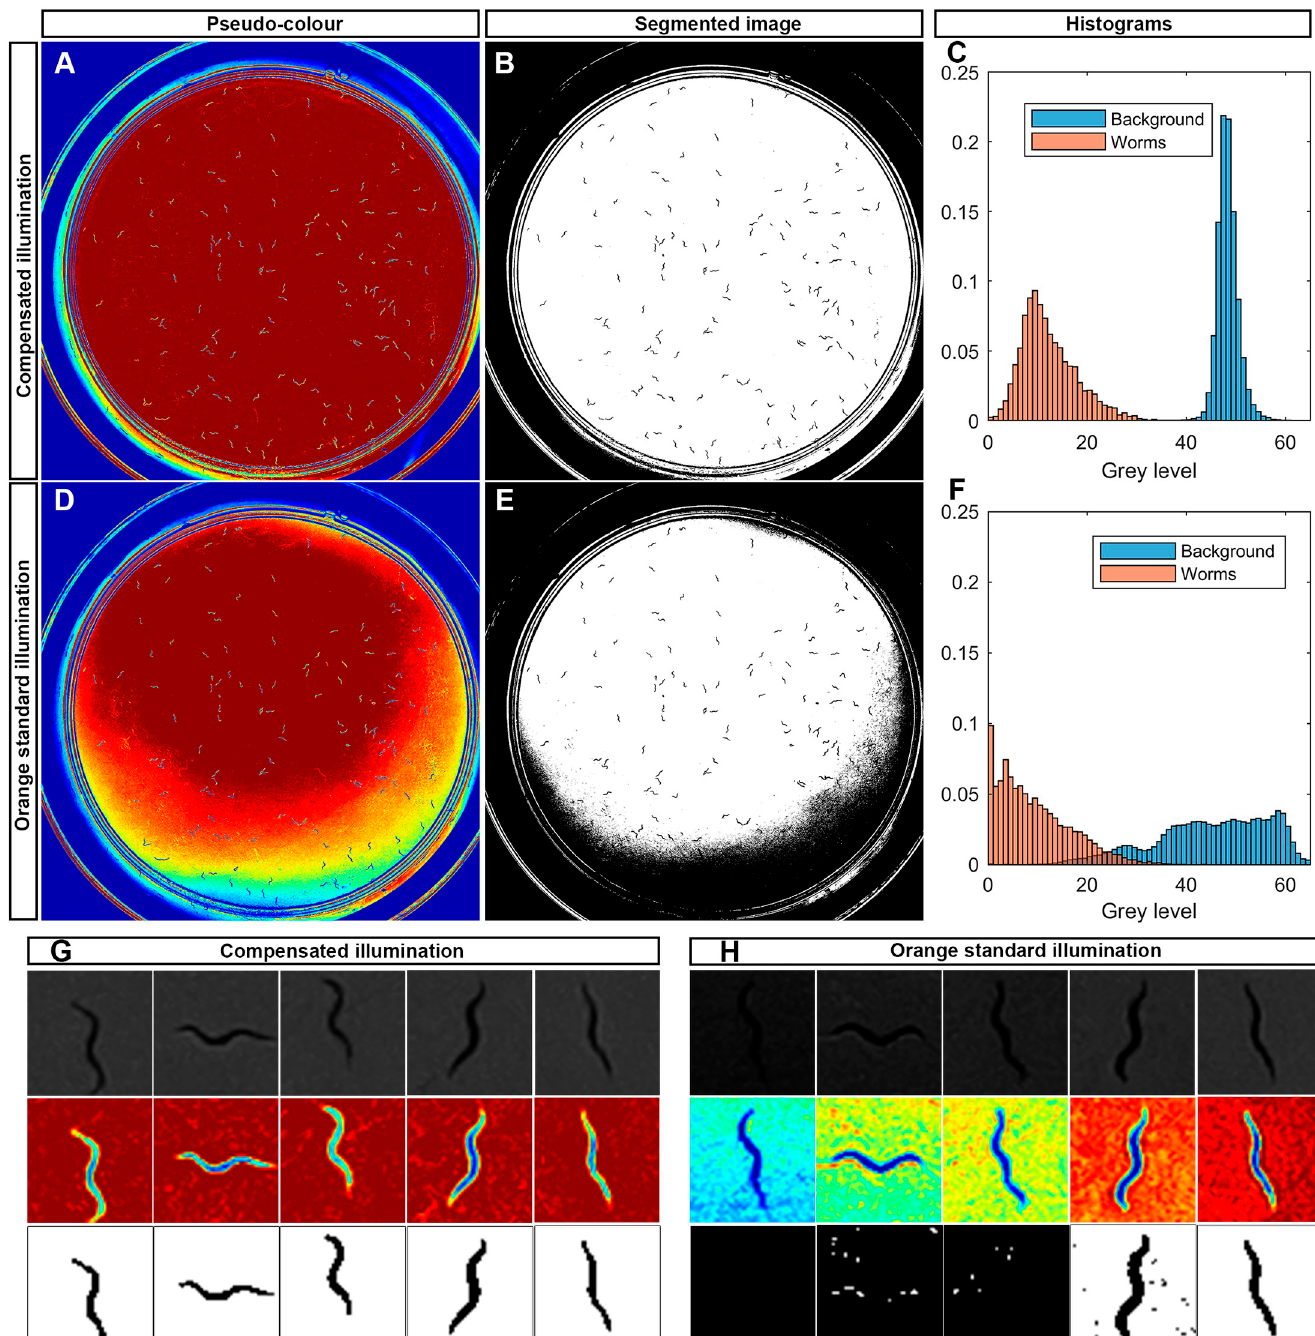
Fig 7. Spatial variability under orange light. A: Captured image pseudo-colour with compensated illumination. B: Segmented image of (A) by a threshold method. C: Histogram of grey level of background (blue) and worms (red) from (A). D: Captured image pseudo-colour with orange standard illumination. E: Segmented image of (D) by a threshold method. F: Histogram of grey level of background (blue) and worms (red) from (D). G: Worm image examples from (A) in pseudo-colour, grey scale and segmented. H: Worm image examples from (D) in grey scale, pseudo-colour and segmented.